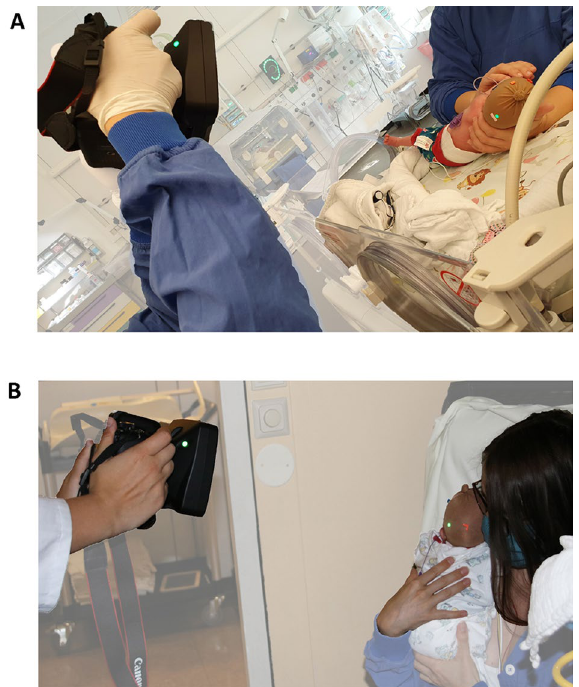
Figure 2. Display of the parameters for measurements of the infants’ heads. ( A ) Transversal view and ( B ) side view. CV cranial volume; ML measurement level; N* nasion*; Tr_l/r tragus left/right.